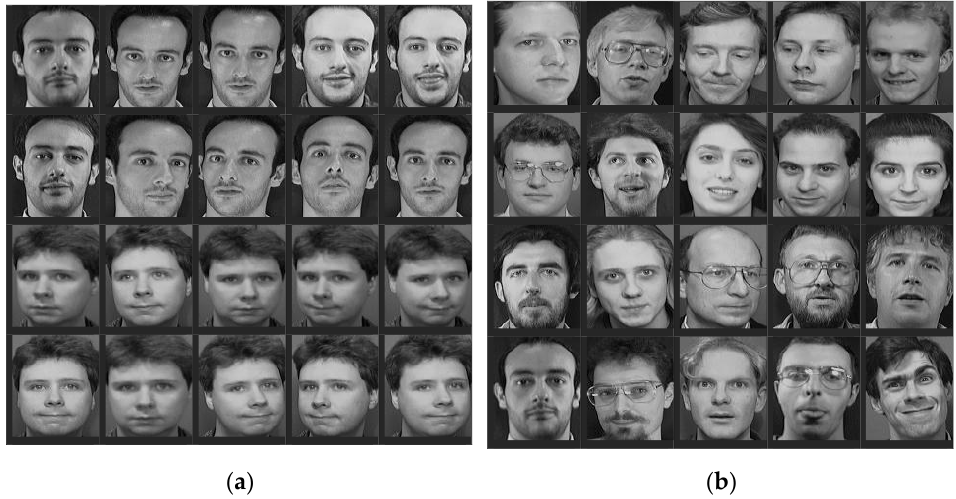
Figure 1. Sample face images ( a ) different poses of two people ( b ) different poses of various people. 2.